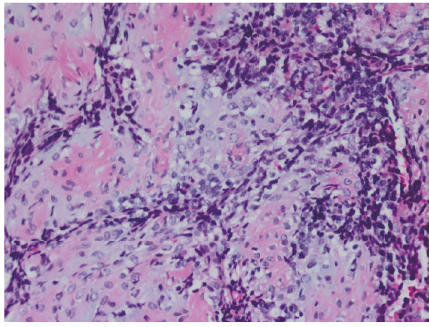
Figure 2: 10x magnification of chondroid and mesenchymal portions.